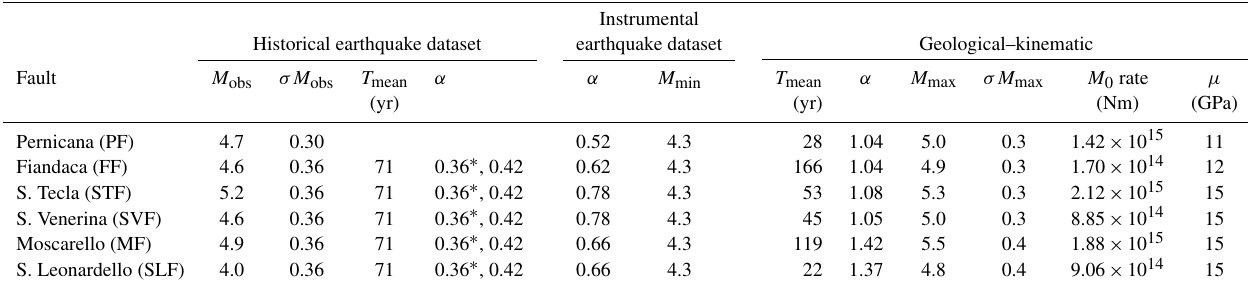
Table 1. Comparison with estimations based on historical and instrumental earthquake datasets; the explanation of the geological–kinematic approach is given in Sect. 5. Abbreviations: T mean is the mean recurrence time; α is the aperiodicity factor; M max is the maximum magnitude obtained by the FiSH code and related standard deviation ( σM max ); M 0 is the moment rate; µ is the shear modulus; M min is the minimum magnitude of the instrumental earthquake dataset. Asterisk indicates the value obtained by the bootstrap analysis. Instrumental Historical earthquake dataset earthquake